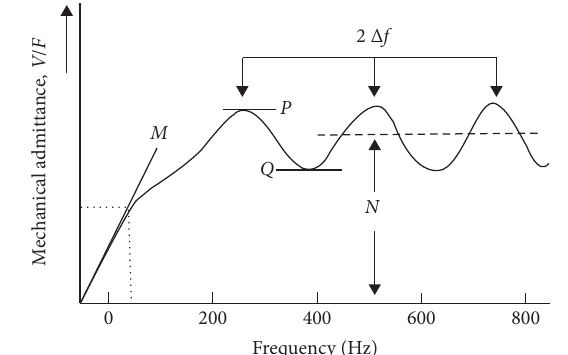
Figure 1: Theoretical mobility response spectrum tested by TRM